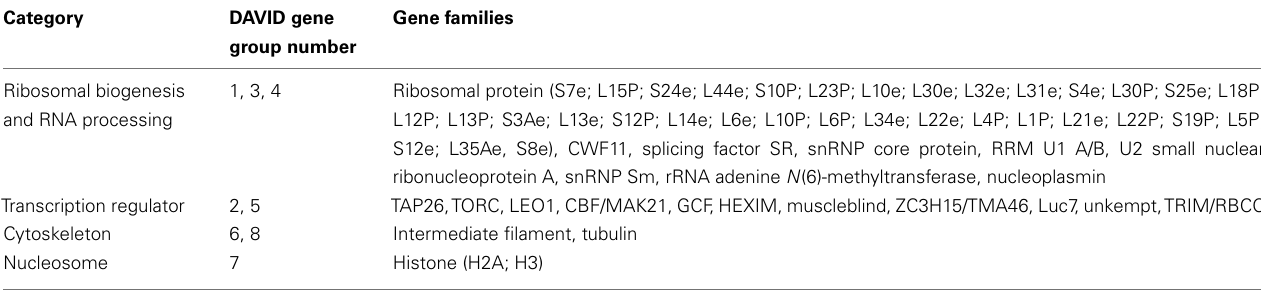
Table 2 | Gene families of down-regulated genes in 4-day hyperglycemic MBL null mice compared toWT